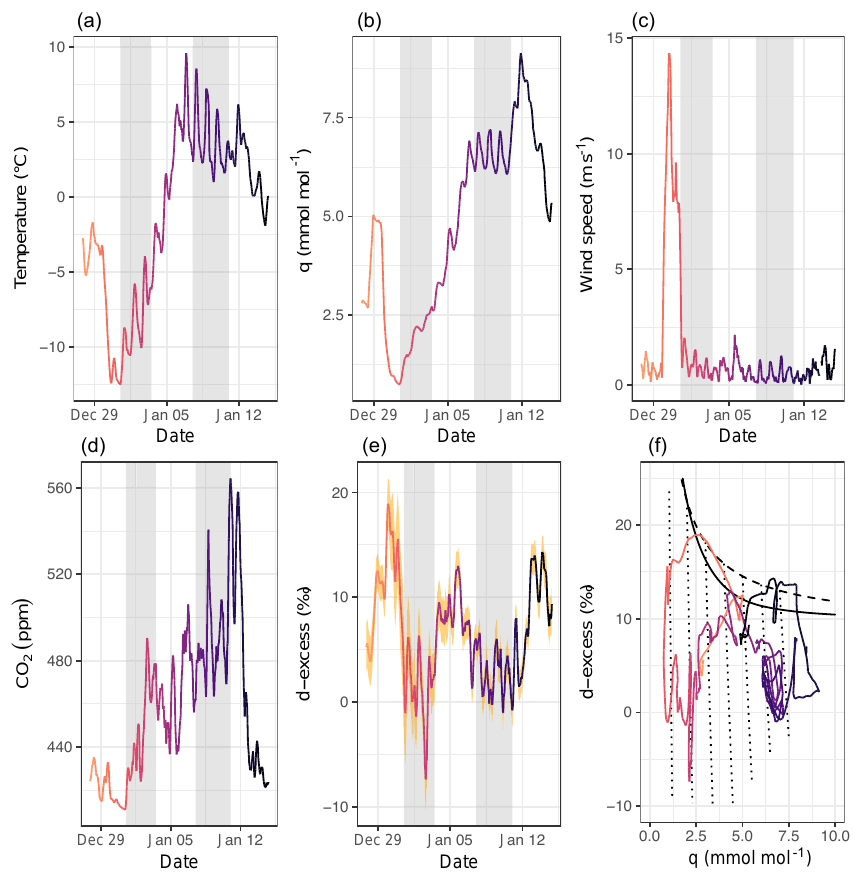
Figure 6. Relationships between meteorology, d-excess, and CO 2 from 28 December 2014 to 14 January 2015. Time series of temperature ( a , ◦ C), q , ( b , mmolmol − 1 ), wind speed ( c , ms − 1 ), CO 2 ( d , ppm; 1 σ uncertainty in orange shading), d-excess ( e , ‰), and the relationship between dq and q (f) spanning the same time period, with the same color gradient used across time in all four panels. Data are plotted as 6h running